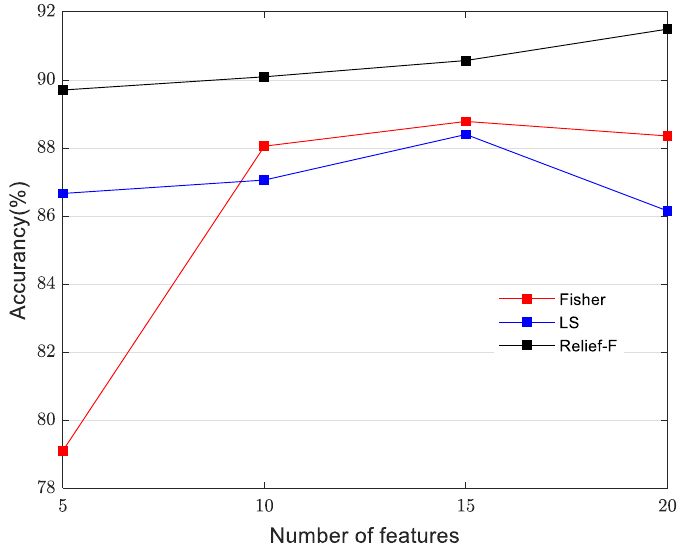
Figure 15. The identification accuracy of different hybrid optimization methods.